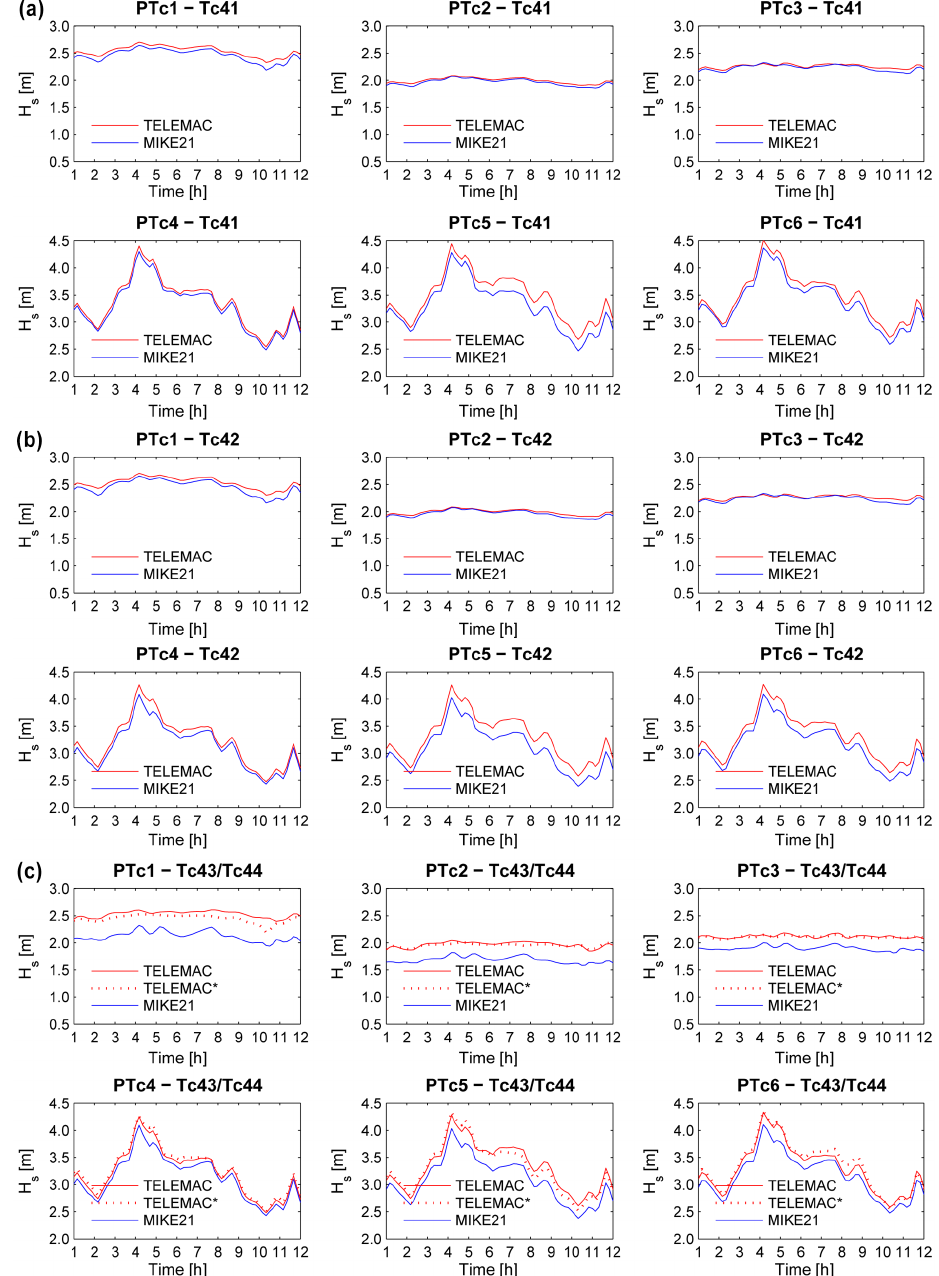
Figure 11. Comparison of TELEMAC and MIKE21 results ( H s ) at points within (PTc1, PTc2, PTc3) and outside of the breaker zone (PTc4, PTc5, PTc6) for the Brindisi–Torre Guaceto case study for runs (a) Tc41, (b) Tc42 and (c) Tc43/Tc44 ∗